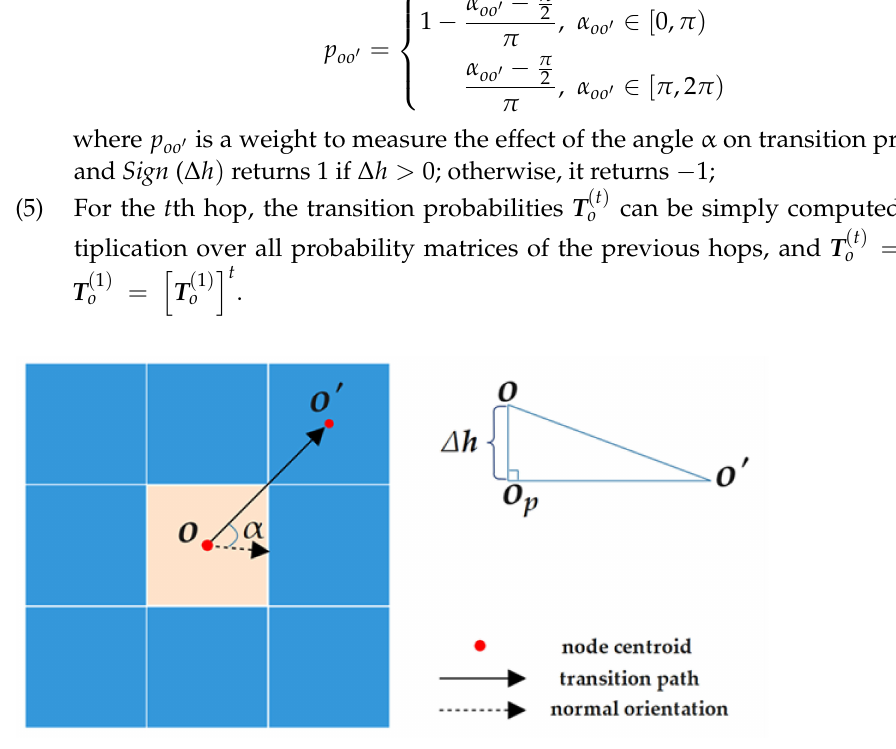
Figure 4. Transition distance calculation.